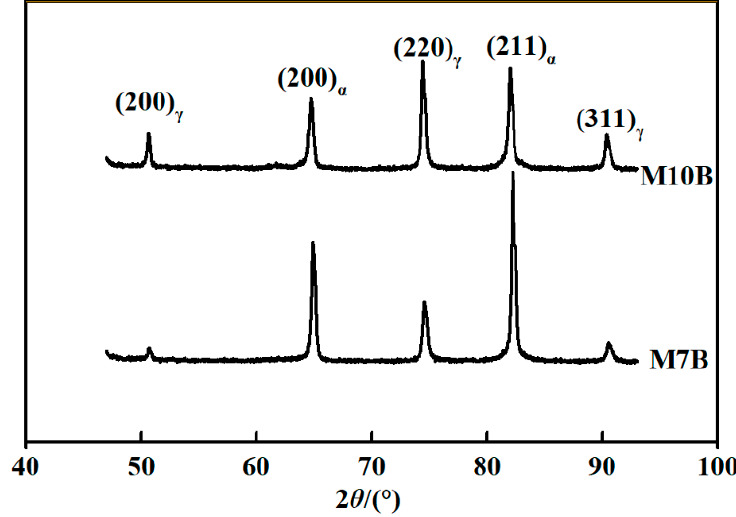
Figure 1. X-ray diffraction (XRD) patterns of M7B and M10B. Figure 1. X-ray di ff raction (XRD) patterns of M7B and